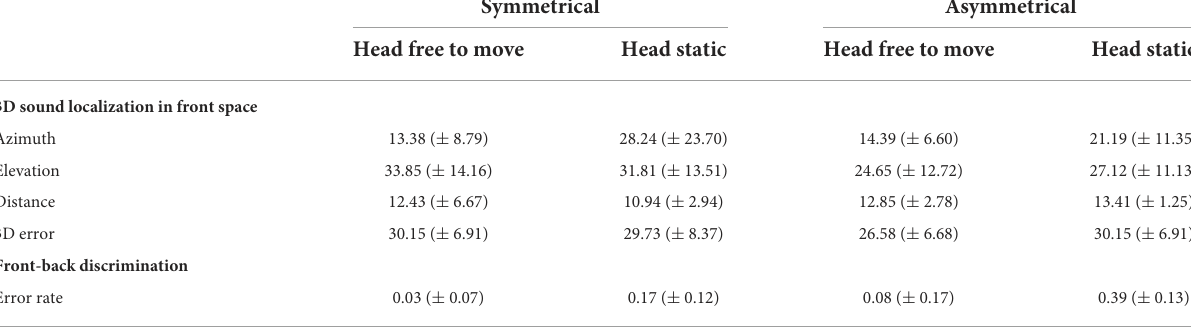
TABLE 2 Effects of spontaneous head-movements on symmetrical and asymmetrical ARHL participants.